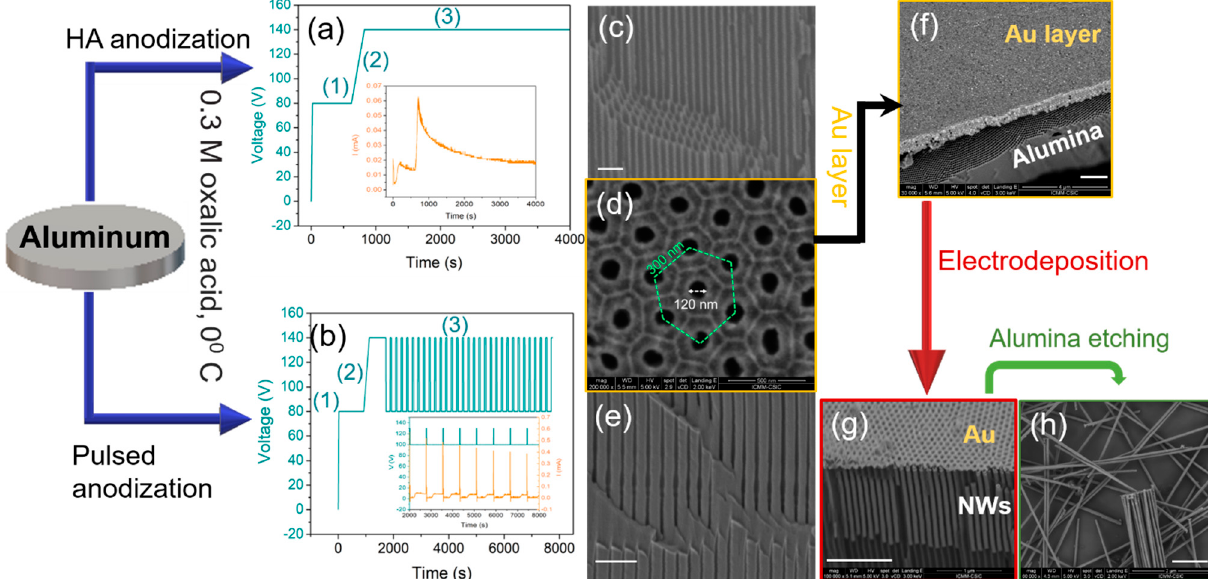
Figure 1. Illustration of the fabrication process. ( a ) Voltage–time transients of hard anodization. The inset shows the current during the anodization, ( b ) Voltage–time transients of pulsed hard anodization, including the first anodization step (1), ramping of voltage (2), and the applied pulses (3). The inset shows a close look of both applied voltage and current transients, during the pulsed anodization, ( c ) Cross-section Scanning Electron Microscopy (SEM) image of alumina templates prepared by hard anodization with pores of uniform diameter of 120 nm, ( d ) Top view SEM image of the bottom side of alumina template presented in ( c , e ) Cross-section SEM image of alumina template prepared by pulsed anodization with modulated pores, ( f ) SEM image of an Au layer deposited on the bottom of alumina template, ( g ) cylindrical nanowires deposited by electrodeposition inside the alumina pores, ( h ) individual nanowires released from alumina templates by chemical etching. The scale bar in ( c , e – h ) is 1 μ m.